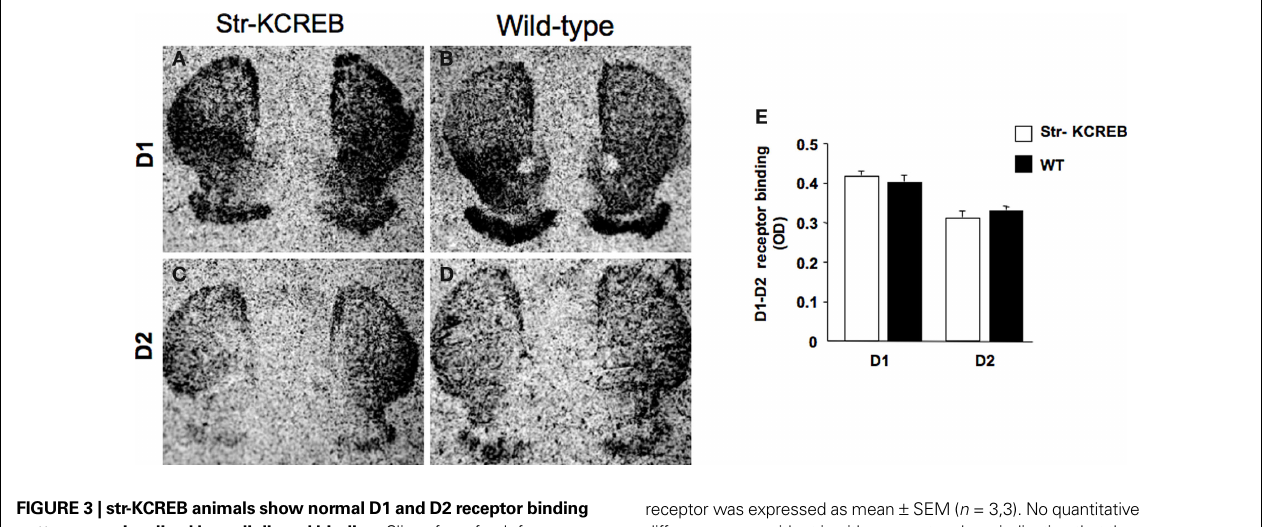
FIGURE 3 | str-KCREB animals show normal D1 and D2 receptor binding patterns, as visualized by radioligand binding. Slices from fresh frozen brains of str-KCREB and control mice were probed with D1 (A,B) and D2 radioligands (C,D) . (E) Optical density (OD) value relative to